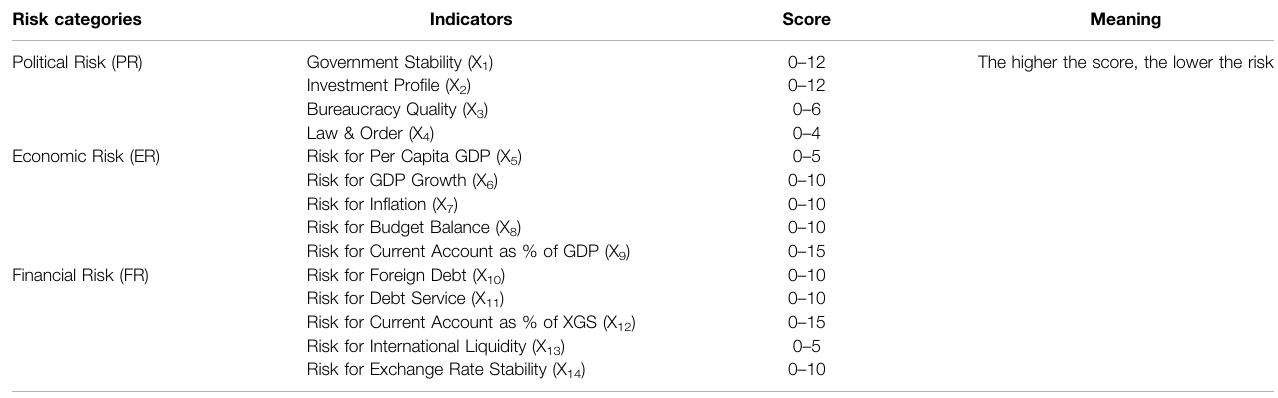
TABLE 1 | National risk index system of host country.